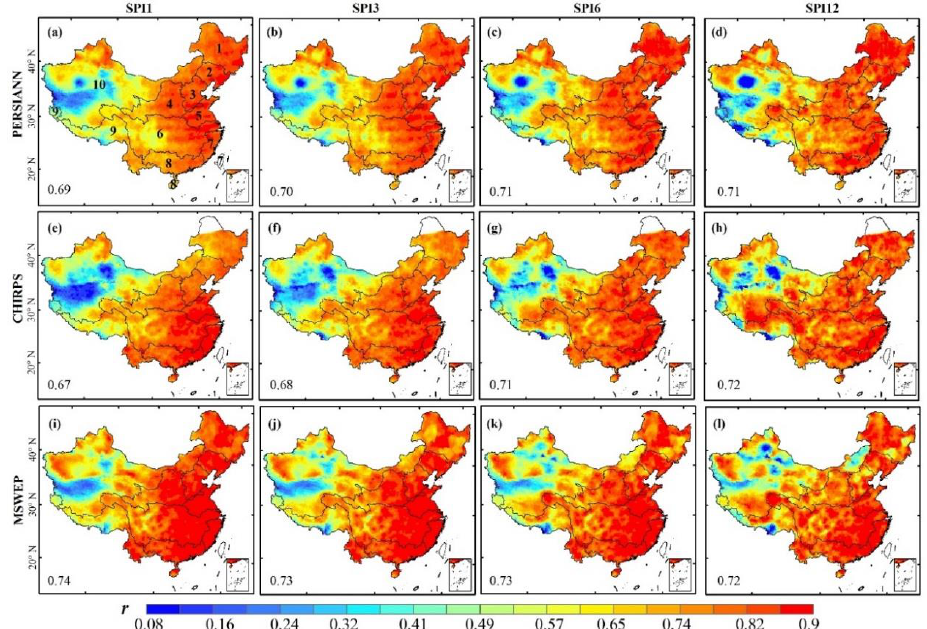
Figure 7. Spatial distribution of correlation coefficients of the SPI estimated from PERSIANN ( a – d ), CHIIRPS ( e – h ) and MSWEP ( i – l ) with CMA. The numbers in ( a ) indicate: 1—the Song Hua River, 2—the Liao River, 3—the Hai River, 4—the Yellow River, 5—the Huai River, 6—the Yangtze River, 7—southeastern rivers, 8—the Pearl River, 9—southwestern rivers, 10—northwestern rivers.